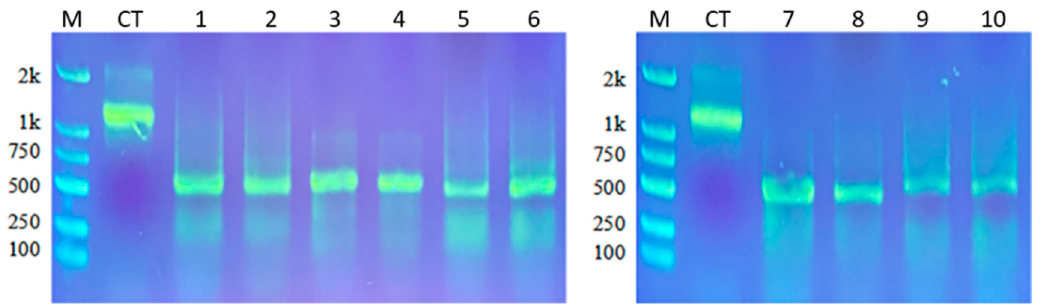
Figure 3. Results of dsRNA synthesis. M: Marker CT: Control Template 1–2: EoACP138 dsRNA 3–4: EoCYP316 dsRNA 5–6: EoCarE592 dsRNA 7–8: EoAchE989 dsRNA 9–10: GFP dsRNA .